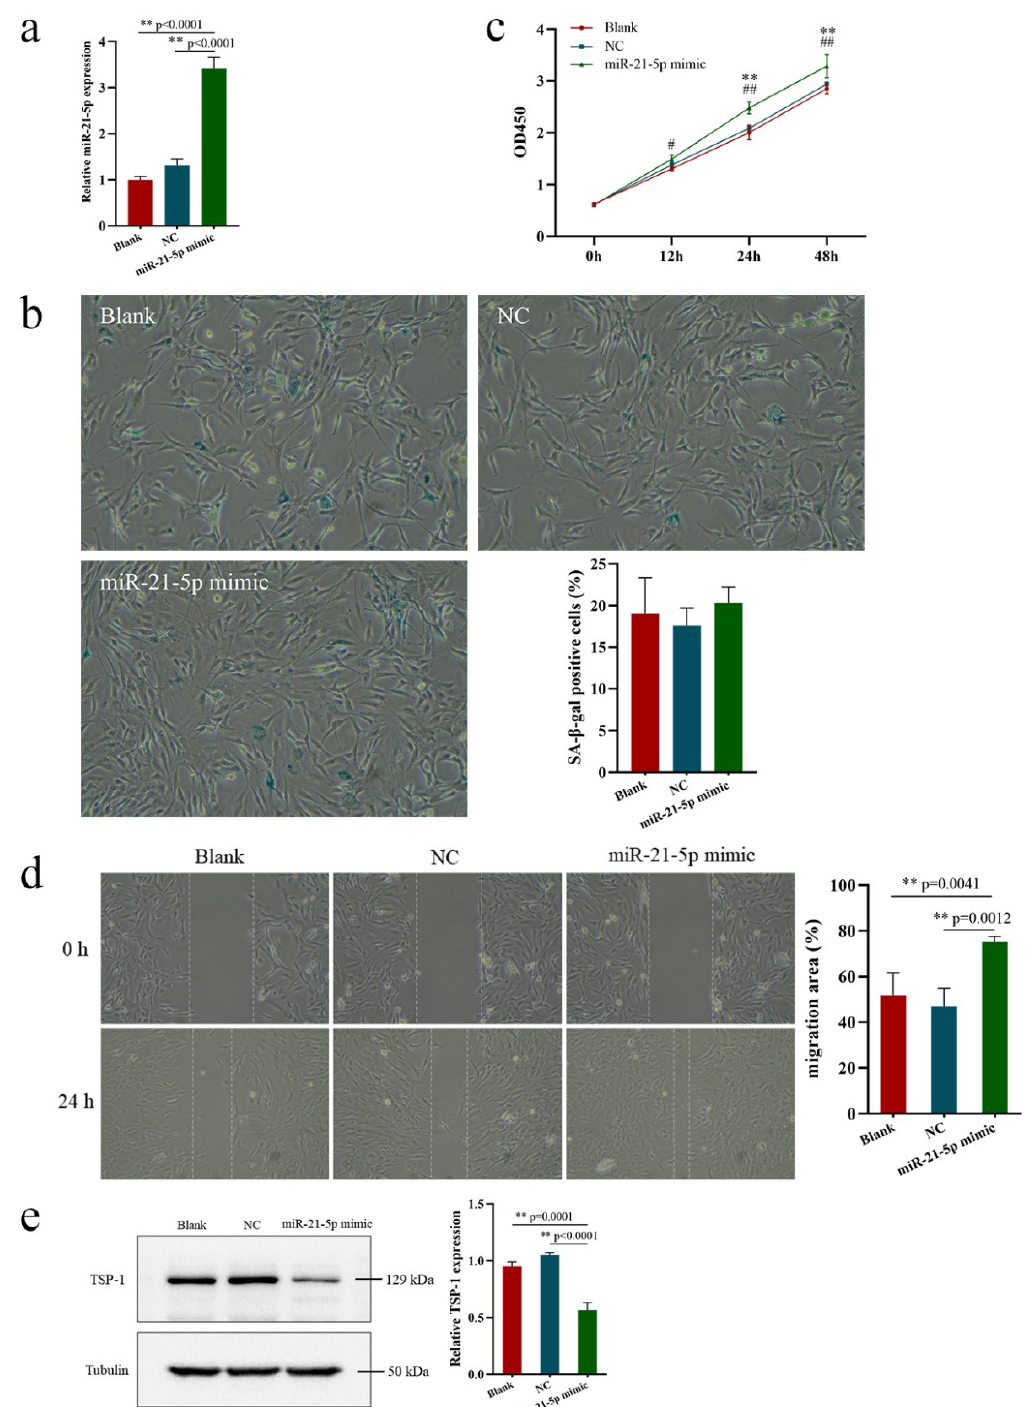
Figure 3. Effects of miR-21-5p overexpression on EPCs function and TSP-1 expression. ( a ) The miR-21-5p expression in EPCs was significantly increased after transfection with mimic for 24 h. ( b ) No significant difference in cell senescence rate after transfection with miR-21-5p mimic for 24 h was found among all the groups. ( c ) Proliferation of EPCs after transfection. ( d ) Migration function of EPCs after transfection. ( e ) The TSP-1 protein expression was significantly lower in the miR-21-5p mimic group than in the NC and blank groups. # p < 0.05, ## p < 0.01, ** p < 0.01. Bar, 100 µ